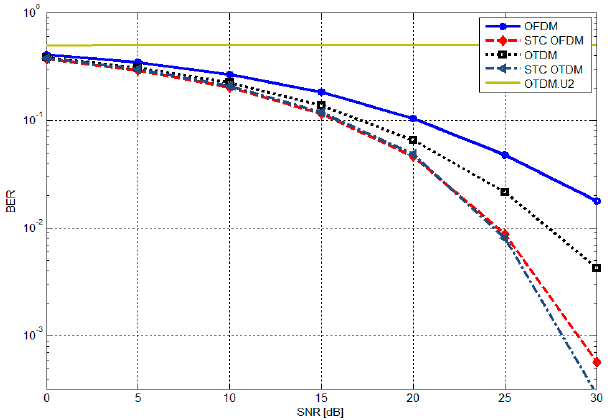
Figure 5. BER of the proposed technique (STC OTDM) in comparison with other multicarrier techniques at N = 16 and L = 9 using 256-QAM.